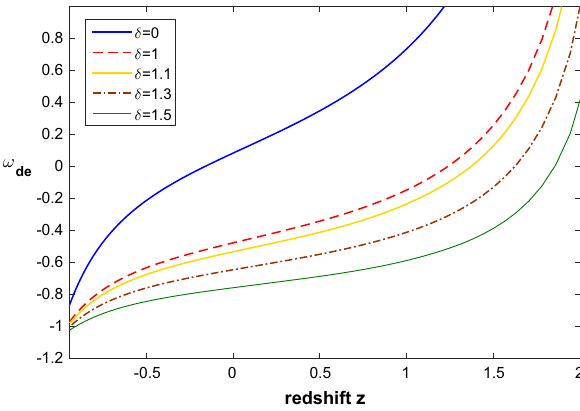
= 0 . 73 and u = 0 . de